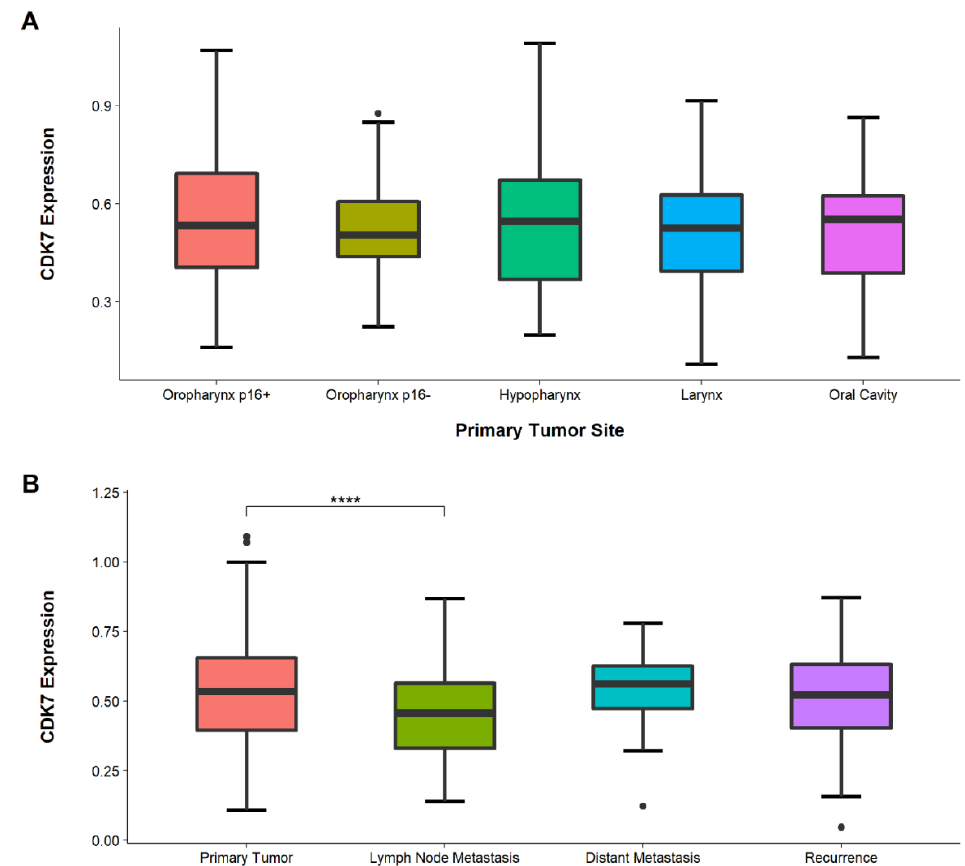
Figure 3. ( A ) Boxplot showing the expression of CDK7 in different HNSCC tumor sites. No significant difference was observed between the locations. ( B ) Boxplot comparing the expression of CDK7 in PTs, LNs, DMs, and RDs. CDK7 expression in LNs was significantly lower compared to PTs ( p < 0.0001, adjusted). Other comparisons did not reach significance ( p > 0.05). **** p < 0.0001, ● Outliers.